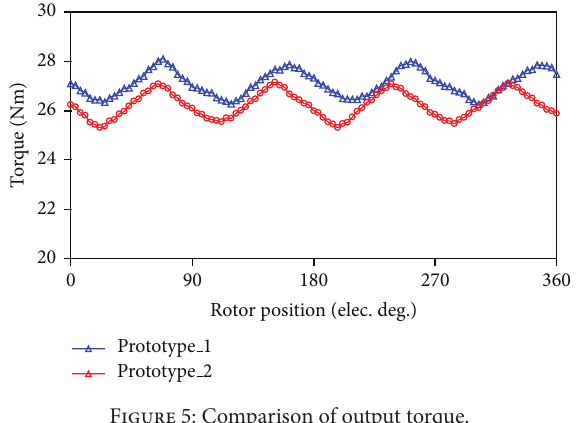
Figure 5: Comparison of output torque.